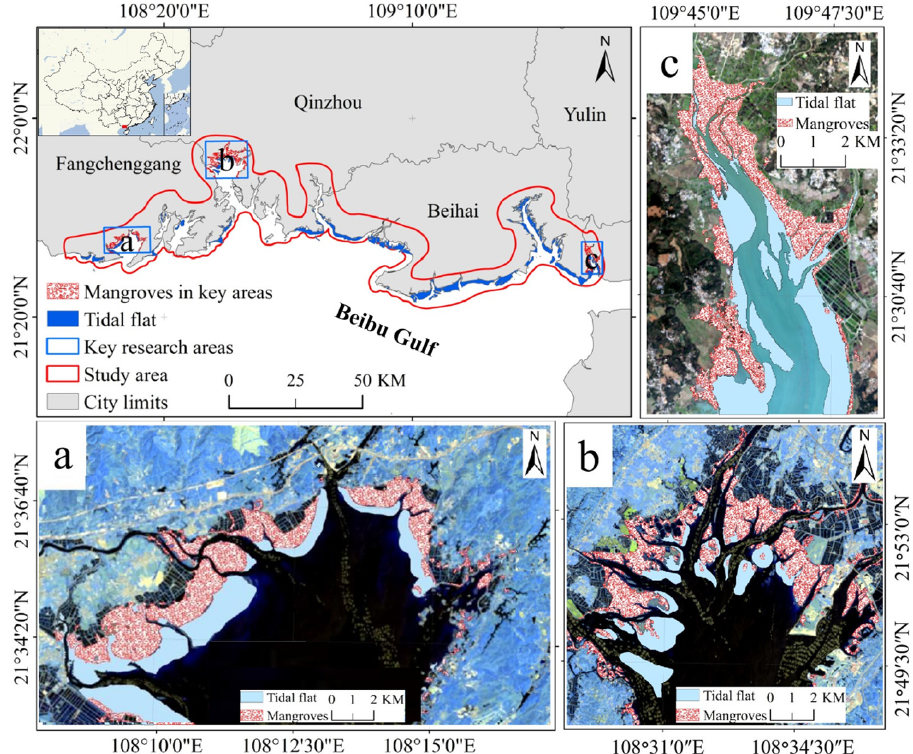
Figure 16. Latest (2021) tidal flats and mangrove distribution in the study area. ( a ) Pearl Bay tidal flats and mangrove distribution. ( b ) Maowei Sea Mangrove Reserve tidal flats and mangrove distribution. ( c ) Shankou Mangrove Reserve tidal fl ats and mangrove distribution.